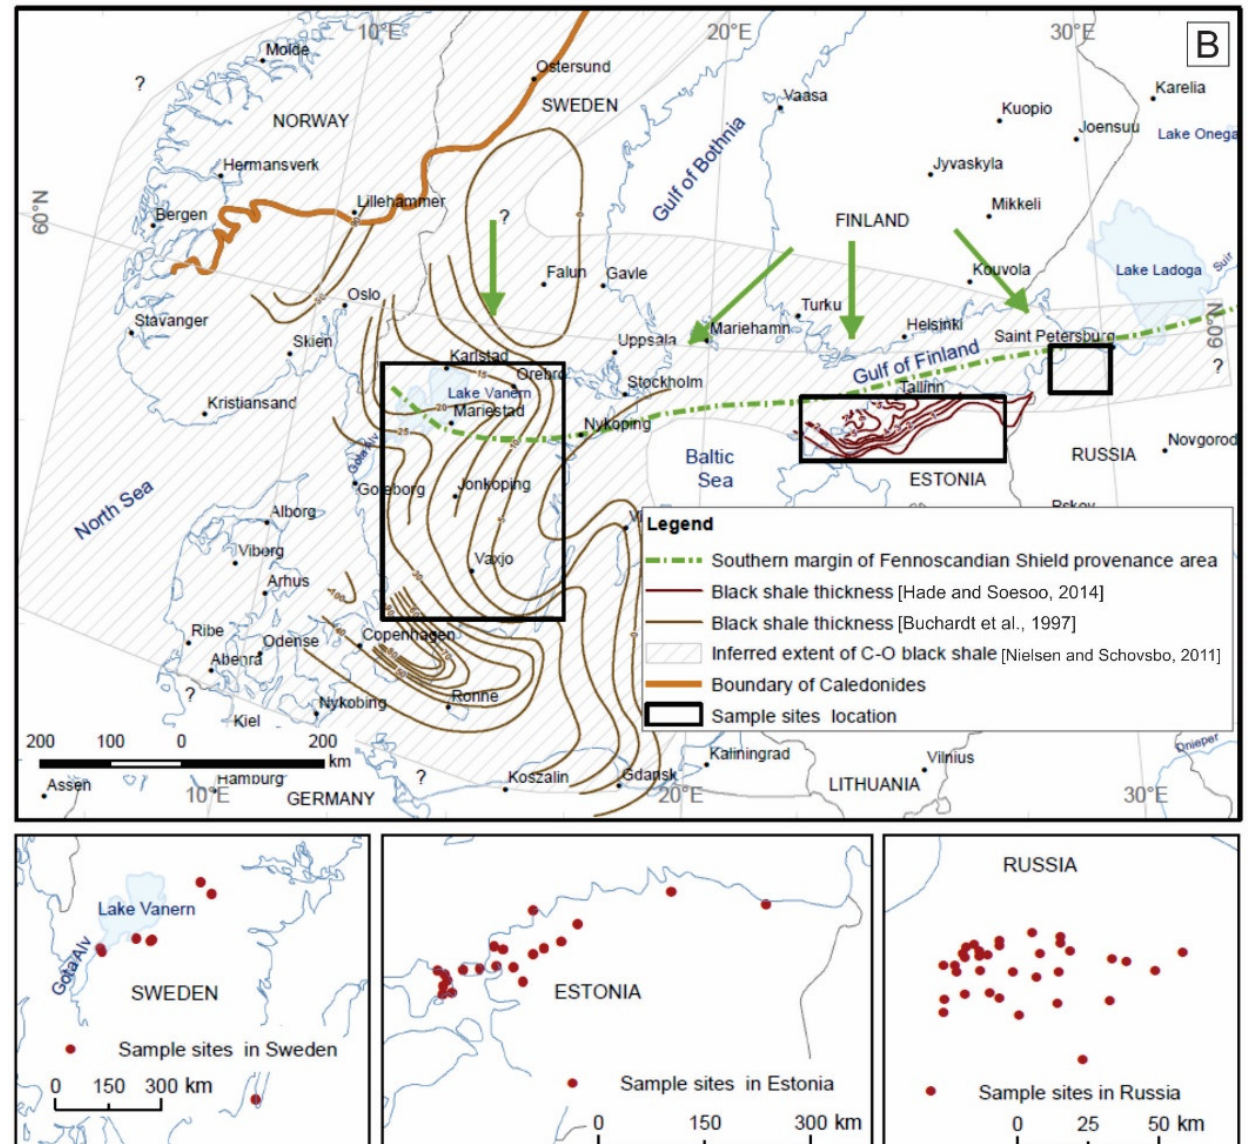
Figure 1. ( A ) Simplified stratigraphy of black shale in the Baltic Paleobasin after [21,37]. ( B ) Map of black shale areas showing sampling points after [24,38,39]. The green arrows represent possible directions of sediment provenance, while dotted green lines represent the southern Fennoscandian landmass between the middle Cambrian to middle Ordovician periods, constructed according to [40], regarding the tectonophysics for those periods. Question mark represents uncertainty in black shale distribution.